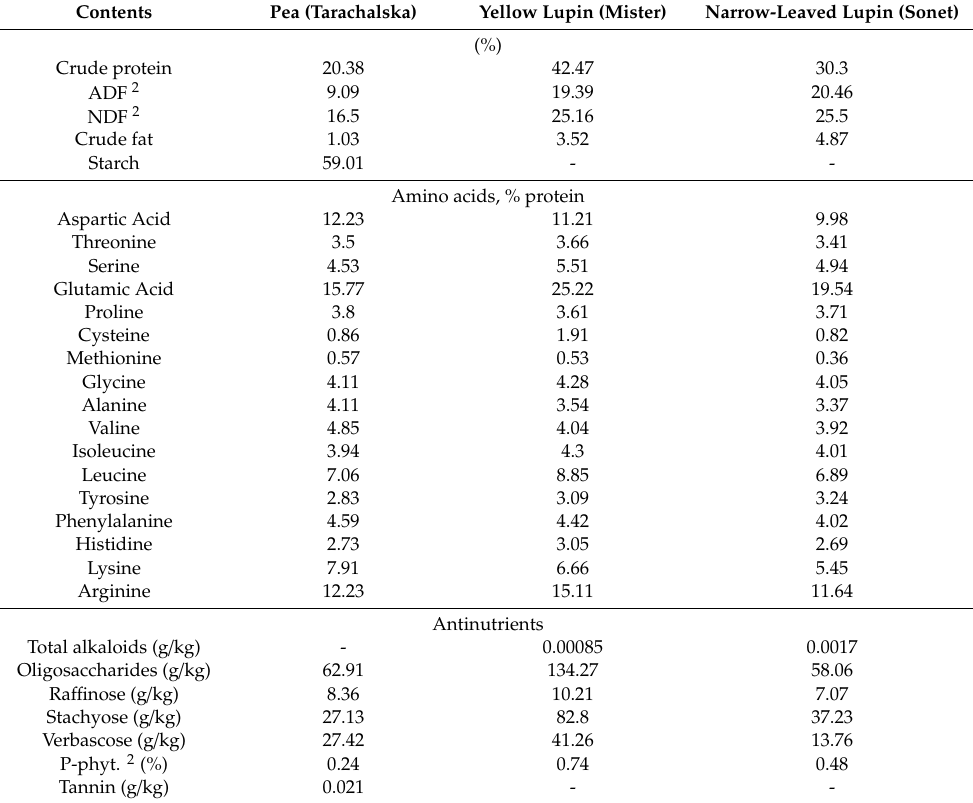
Table 1. Chemical composition of legume seeds (in dry